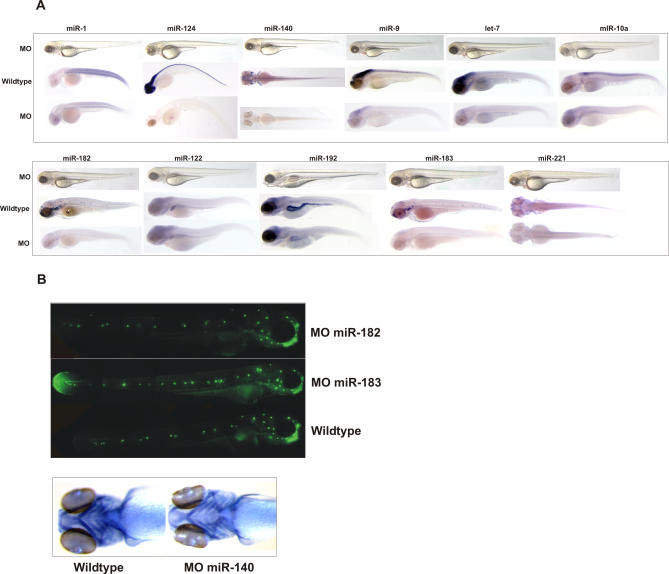
Knockdown of Many miRNAs Does Not Affect Zebrafish Embryonic Development(A) Phenotypes and in situ analysis of 3- and 4-d-old embryos after injection of morpholinos against 11 different mature miRNAs.(B) Daspei staining of 72-h-old embryos injected with MO miR-182 and MO miR-183, and wild-type control (upper panel). Alcian Blue staining of 72-h-old embryos injected with MO miR-140 and noninjected control (lower panel).